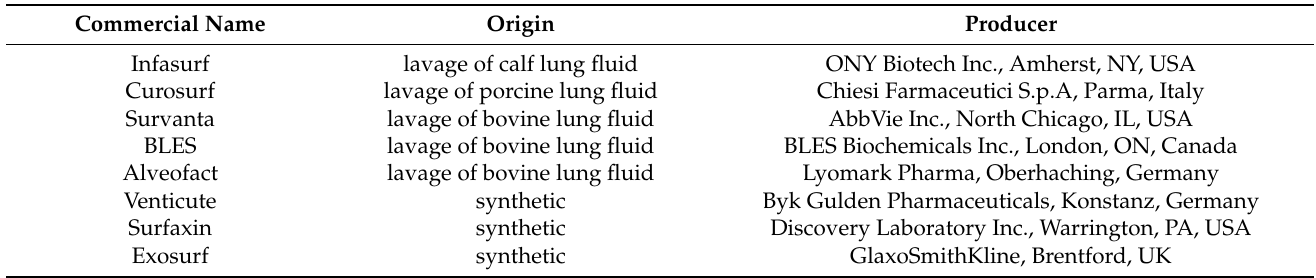
Table 1. Summary of the most extended clinical lung surfactants, together with their type, origin, and